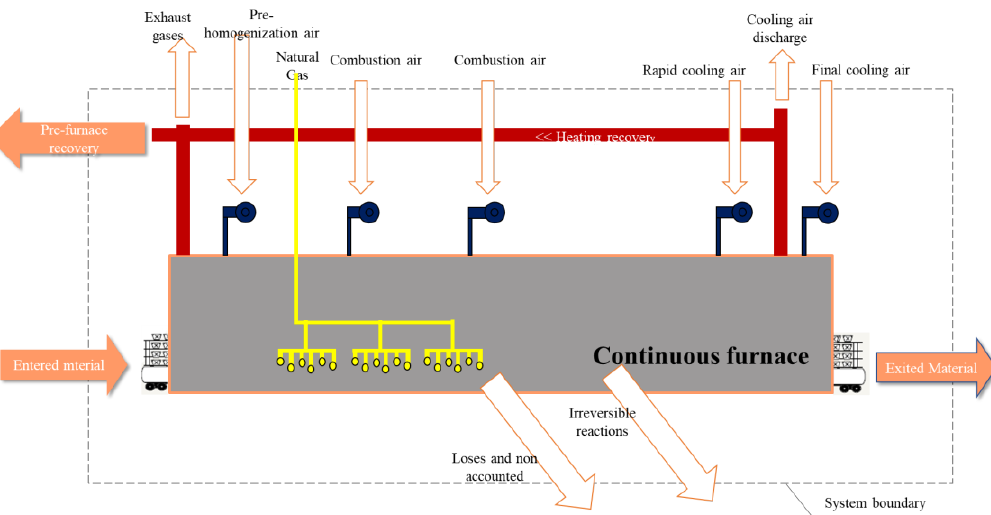
Figure 10. Thermodynamic system of the continuous furnace before the implementation of the measure.